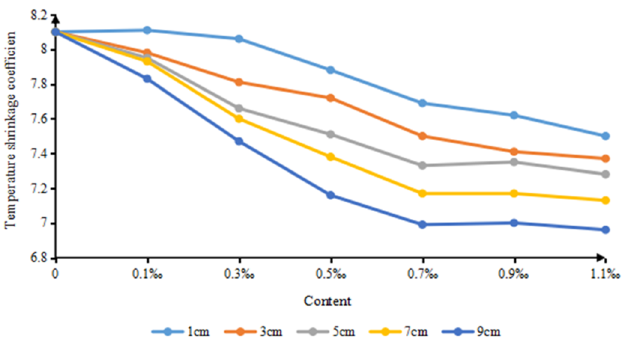
Figure 6. Effects of fiber content on the temperature shrinkage coefficient.